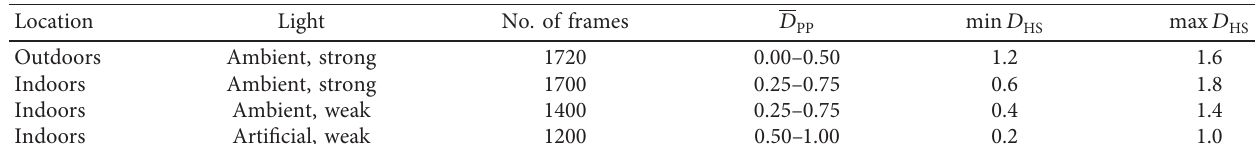
Table 1: Parameters of the video recording experiments. For each experiment, a location, lighting conditions, number of frames, mean distance between persons D , and minimal and maximal distances between a head and the sensor, min D PP Note that individual persons can be present in multiple frames in different positions.